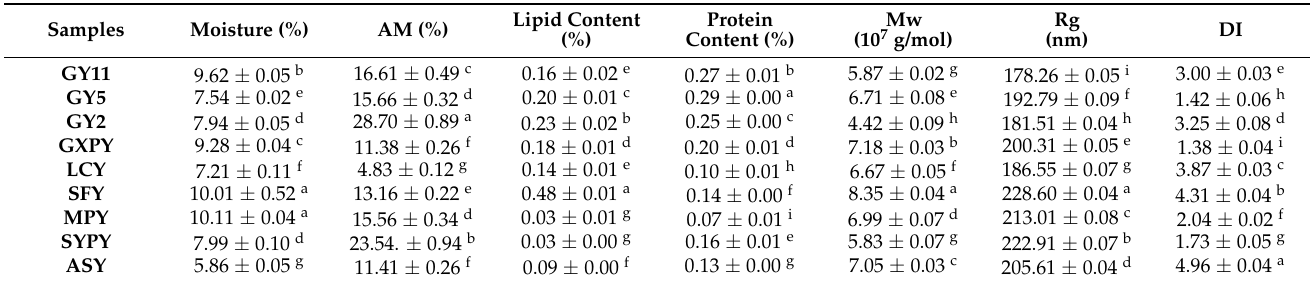
Table 1. Moisture content, amylose content, lipid content, protein content, and molecular features of yam